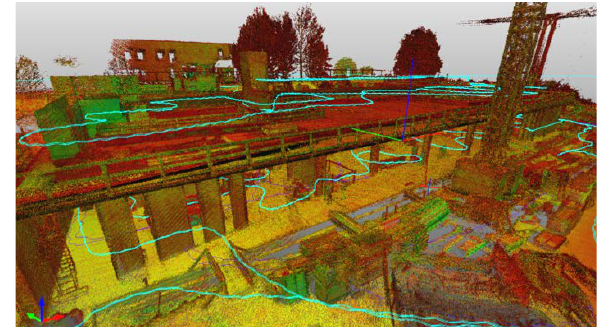
Figure 5. Point cloud with colorization based on reflectance. The trajectory is displayed in cyan.